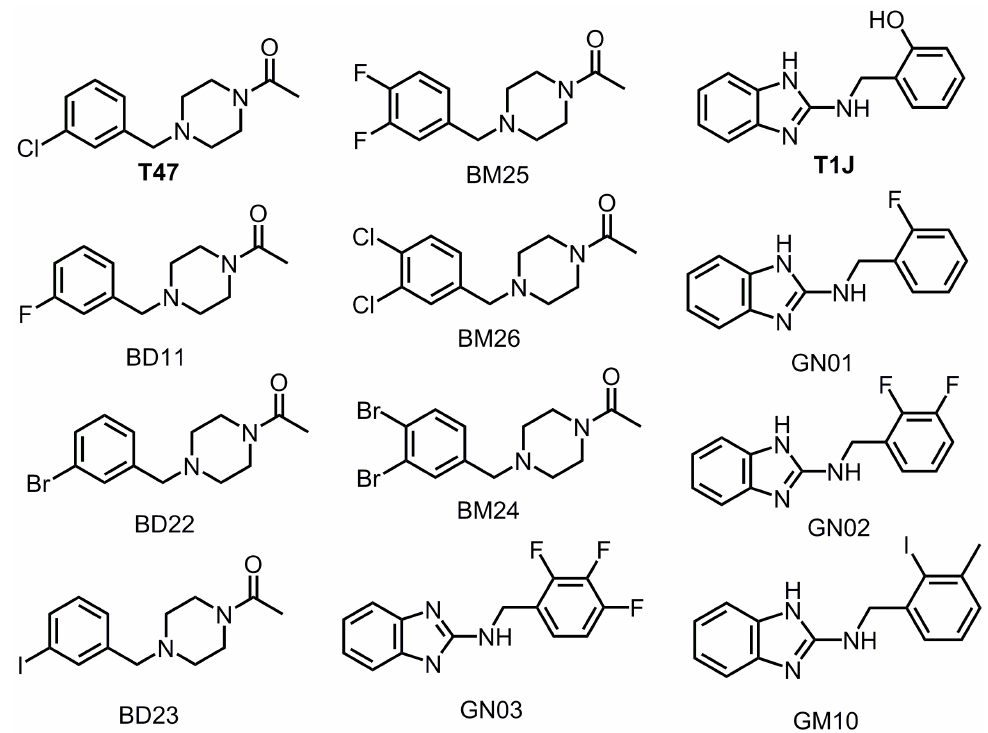
Figure 5. Structures of T47and T1J compound derivatives designed for the halogen